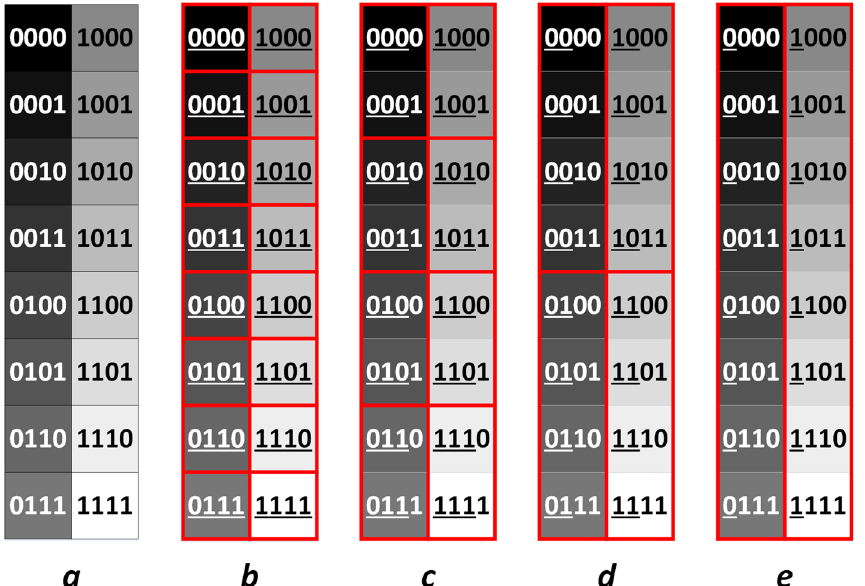
Figure 3. ( a ) The 16 possible states of pixel value qubits under the condition of q = 4. ( b – e ) Selecting the former 4,3,2,1 qubits for comparison. The qubit strings in the same red rectangle are considered